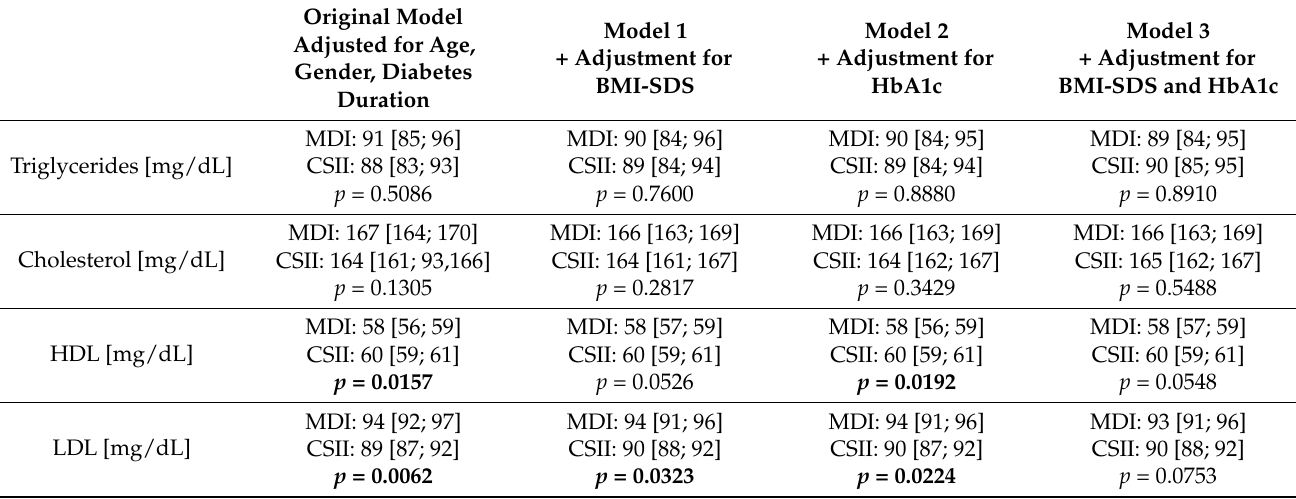
Table 3. Results on lipid values from adjusted linear regression